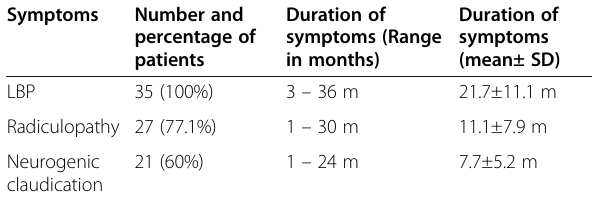
Table 2 Preoperative clinical presentation